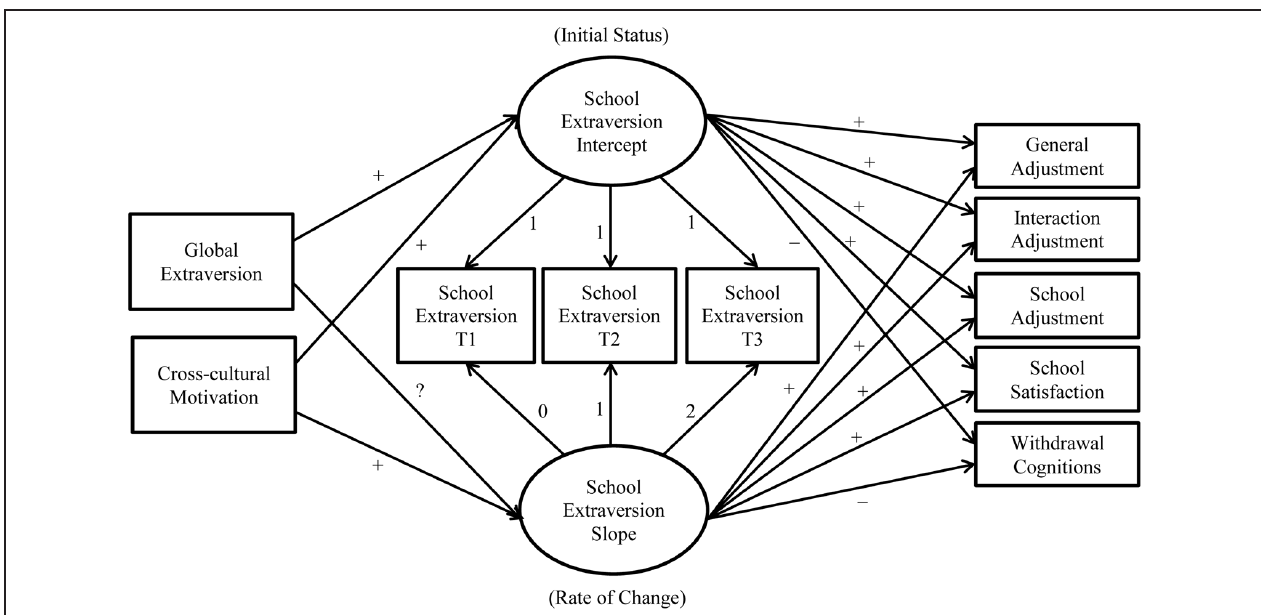
FIGURE 1 | Model 1 with